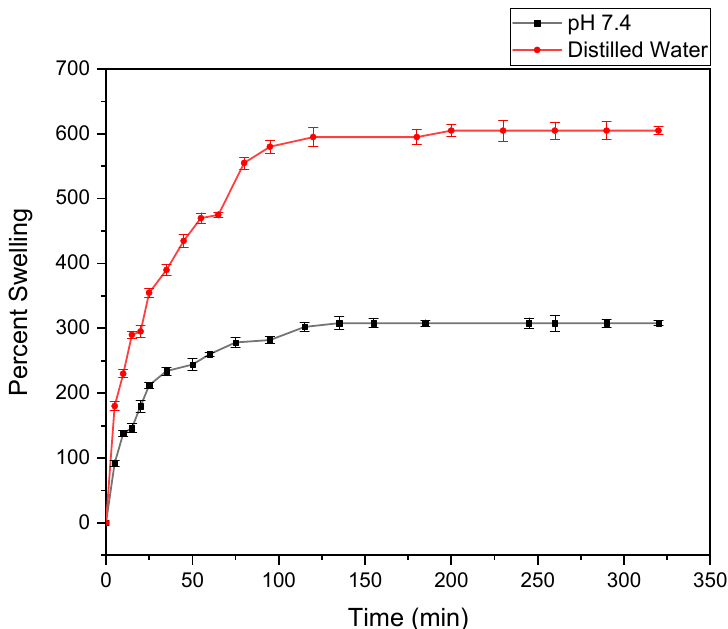
Figure 7. Percent swelling vs. time curve of CNC/PEG/PDMAA semi-IPN hydrogel in water and pH 7.4 phosphate buffer. Table 1. Cytotoxic effect analysis of CNC/PEG/PDMAA semi-IPN hydrogel.